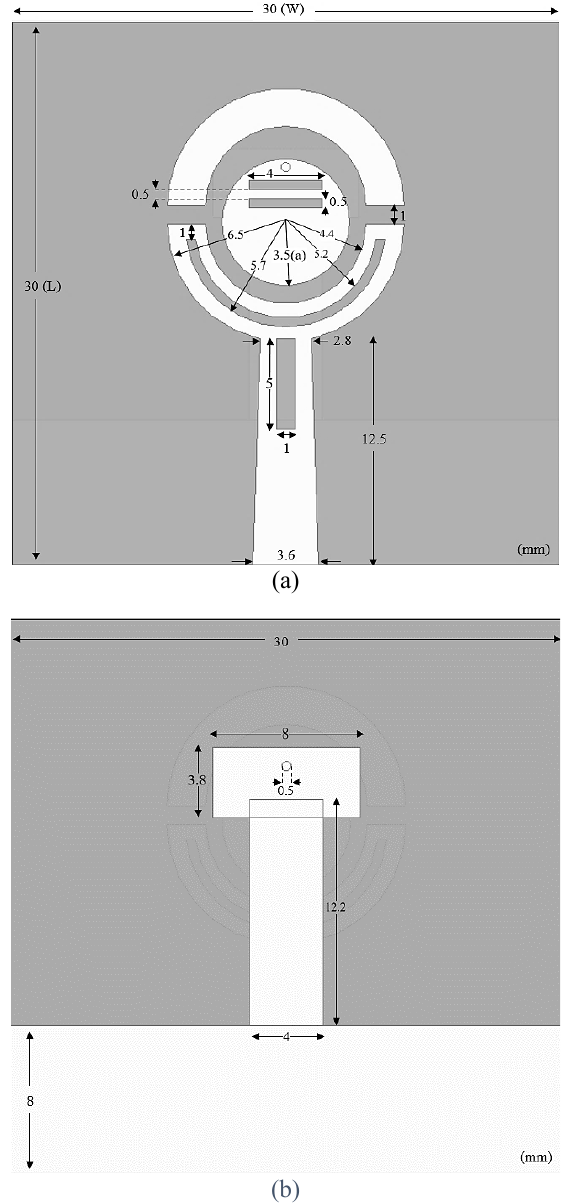
FIGURE 1. Proposed Antenna Configuration (a) Top View (b) Bottom View The top surface of the antenna has a metal via-hole of radius 0.25 mm which connects the circular shape patch with the ground plane as shown in Fig. 1(a). By loading a shorting pin between the circular patch and the ground plane, a significant reduction in size of an antenna is achieved [9]. The circular patch is coupled by two partial annular rings surrounding it. The circular patch on the top of the antenna surface